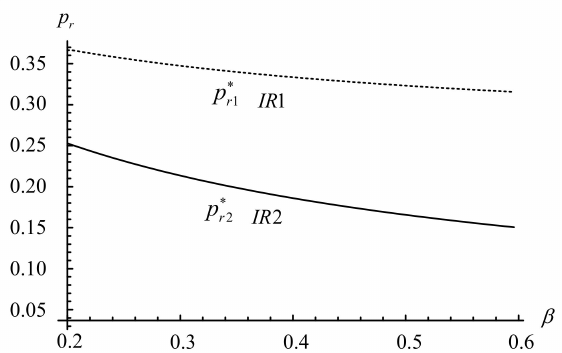
Figure 3. Impact of β on the IR’s prices. Notes: * means the optimal solution in Figures 3–6.